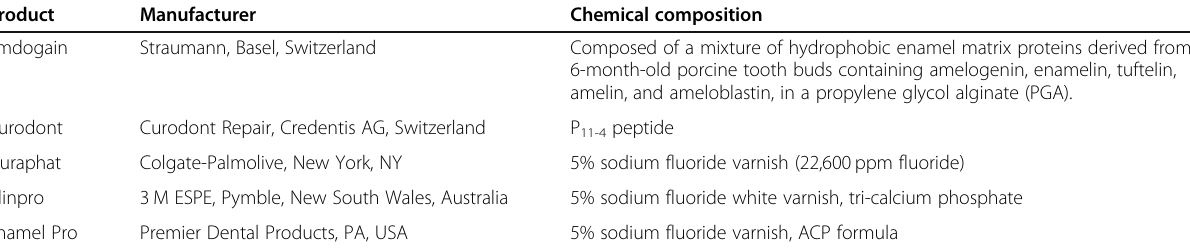
Table 1 Composition of the products according to the manufacturers ’